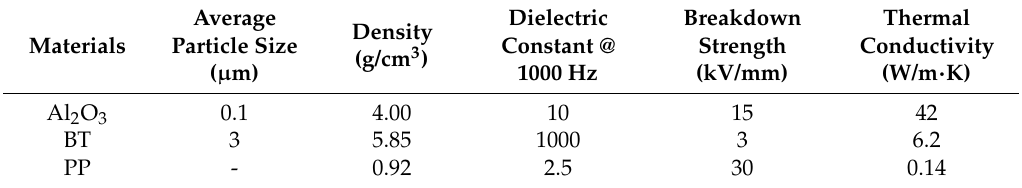
Table 1. The physical properties of Al 2 O 3 , BaTiO 3 particles, and PP